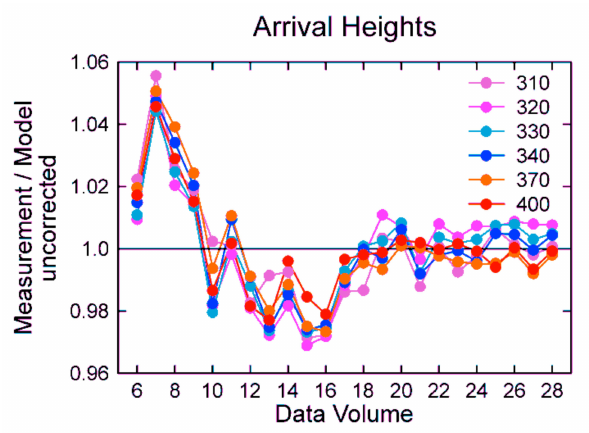
Figure 2. Normalized median ratios of measurement and model at 300, 320, 330, 340, 370, and 400 nm at Arrival Heights. Data were calculated from published